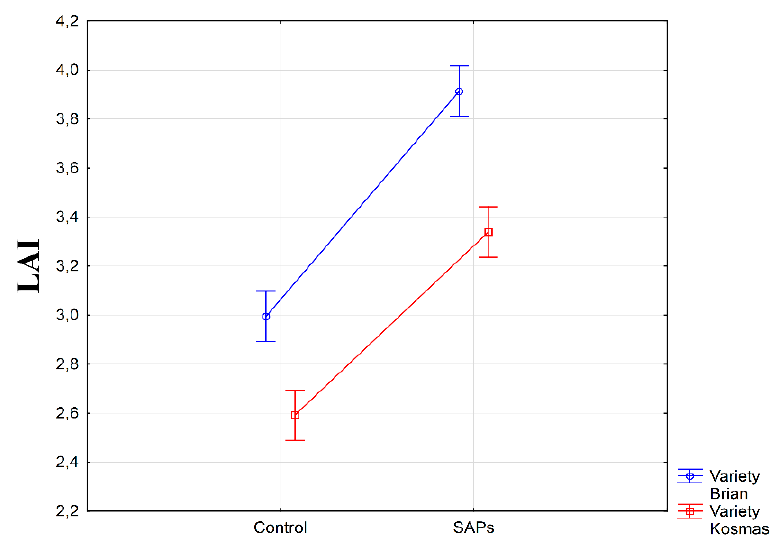
Figure 4. Interaction between experimental treatments and varieties for leaf area index (LAI). Figure was obtained at level of significance α = 0.01.